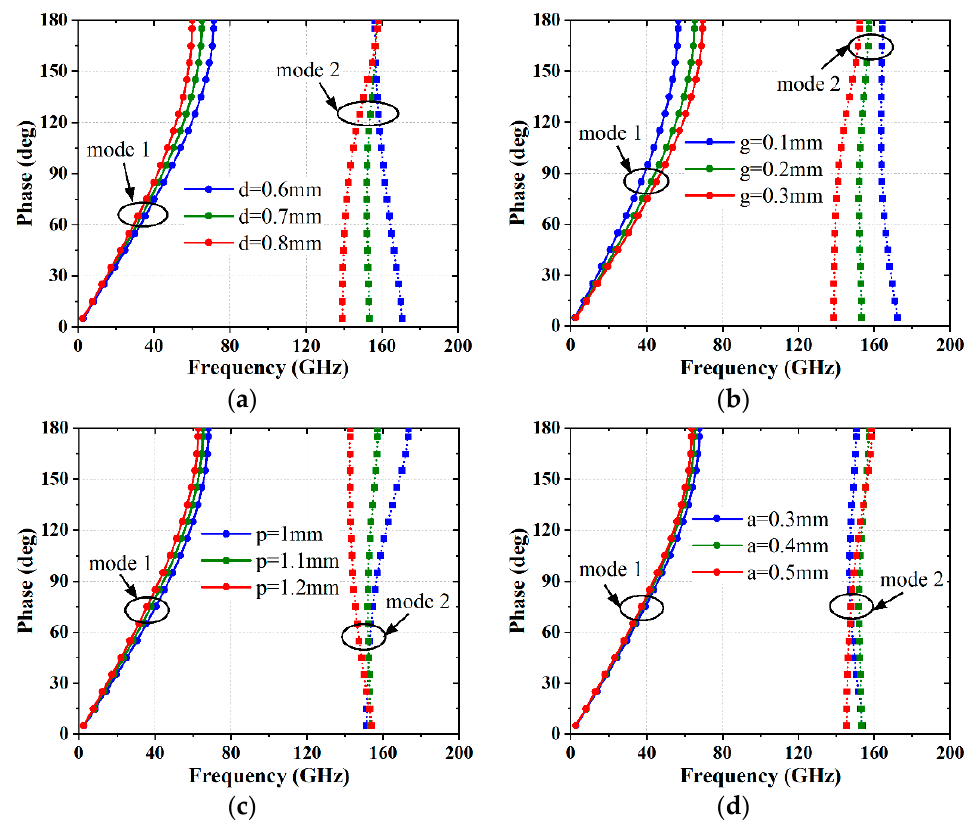
Figure 10. The effect of the unit cell dimensions on the stopband. ( a ) high d . ( b ) gap g . ( c ) interval p . ( d ) pin width a .